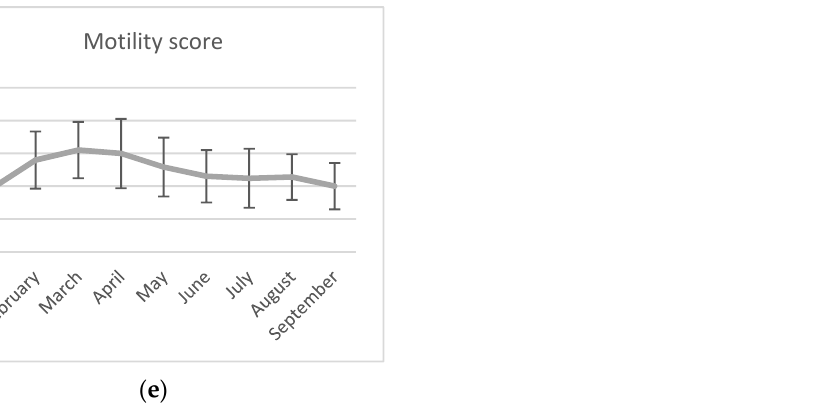
Figure A8. ( a ) Distribution of number of ejaculates collected from January to September (between 2019 to 2021). No ejaculate was collected from October to December; ( b ) mean and standard deviation (SD) of ejaculates volume (µL); ( c ) mean and SD of ejaculates concentration (10 6 spz/mL); ( d ) mean and SD of sperm number ejaculated (10 6 spz) and ( e ) mean and SD of motility score (0 to 5).